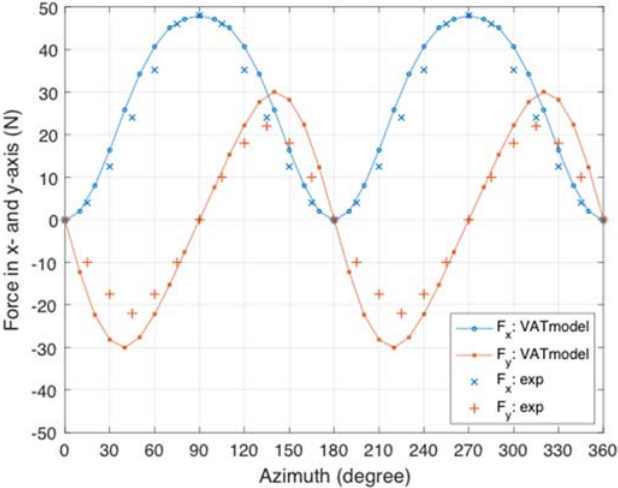
Figure 5. Comparison between predicted and measured [70] thrust and lateral forces on a wind turbine rotor of a two ‐ bladed H ‐ type vertical ‐ axis wind turbine for an incoming flow speed of 4.01 m/s , fixed pitch blade angle of 0 ° , and tip speed ratio of 3.7 .